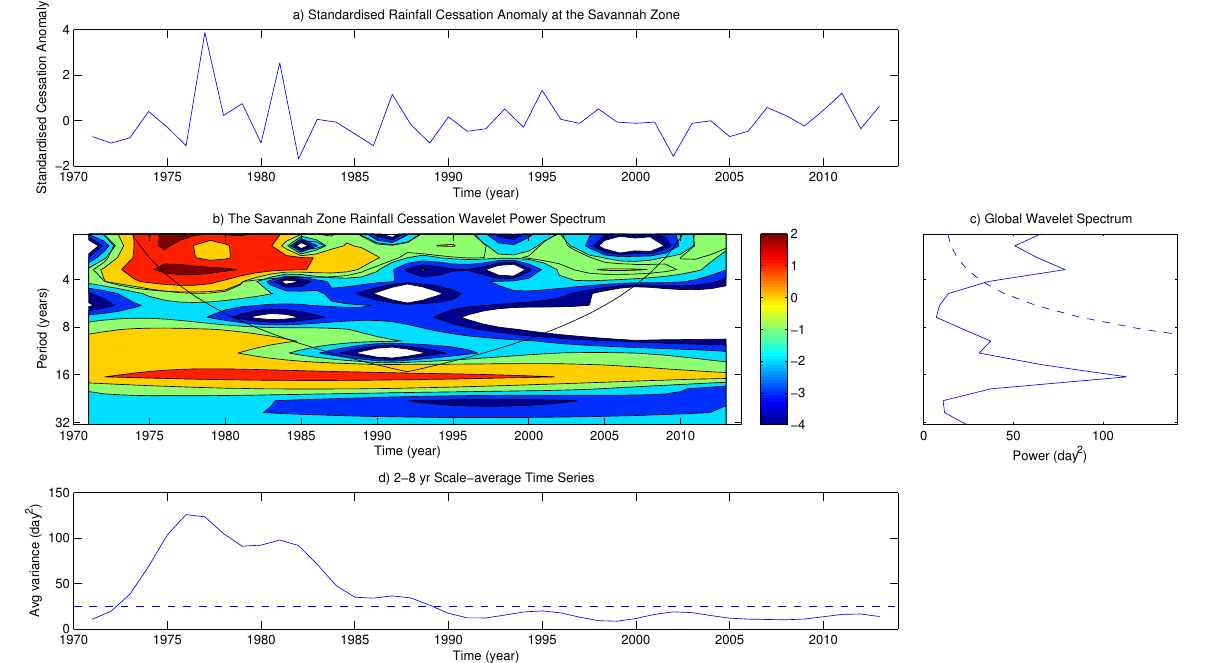
Figure 7. Interannual variability of rainfall cessation dates for the savannah zone using wavelet analysis. ( a ) Standardized anomaly of cessation dates; ( b ) the same as in Figure 6, but for cessation; ( c ) as in Figure 6; ( d ) the same as in Figure 6; the dashed line shows the 95% confidence level.